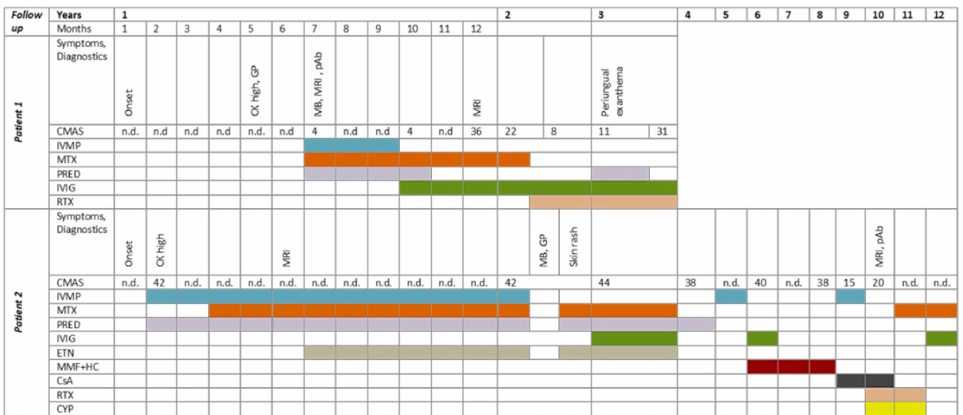
Figure 3. Timelines of both juvenile IMNM patients including onset of symptoms, diagnostics, and applied therapies. Patient 1 was followed for 3 years, and Patient 2 was followed for over 10 years. CMAS = childhood myositis assessment scale, maximal 52 points, CK = creatine kinase, GP = genetic panel, MB = muscular biopsy, MRI= magnetic resonance imaging, CsA = cyclosporine A, CYP = cyclophosphamide, ETN = etanercept, IVMP = intravenous methylprednisolone, MMF + HC = mycophenolate mofetile and hydroxychloroquine, MTX = methotrexate, PRED = prednisolone, RTX = rituximab, Onset = symptom onset, n.d. = not done, pAb = positive